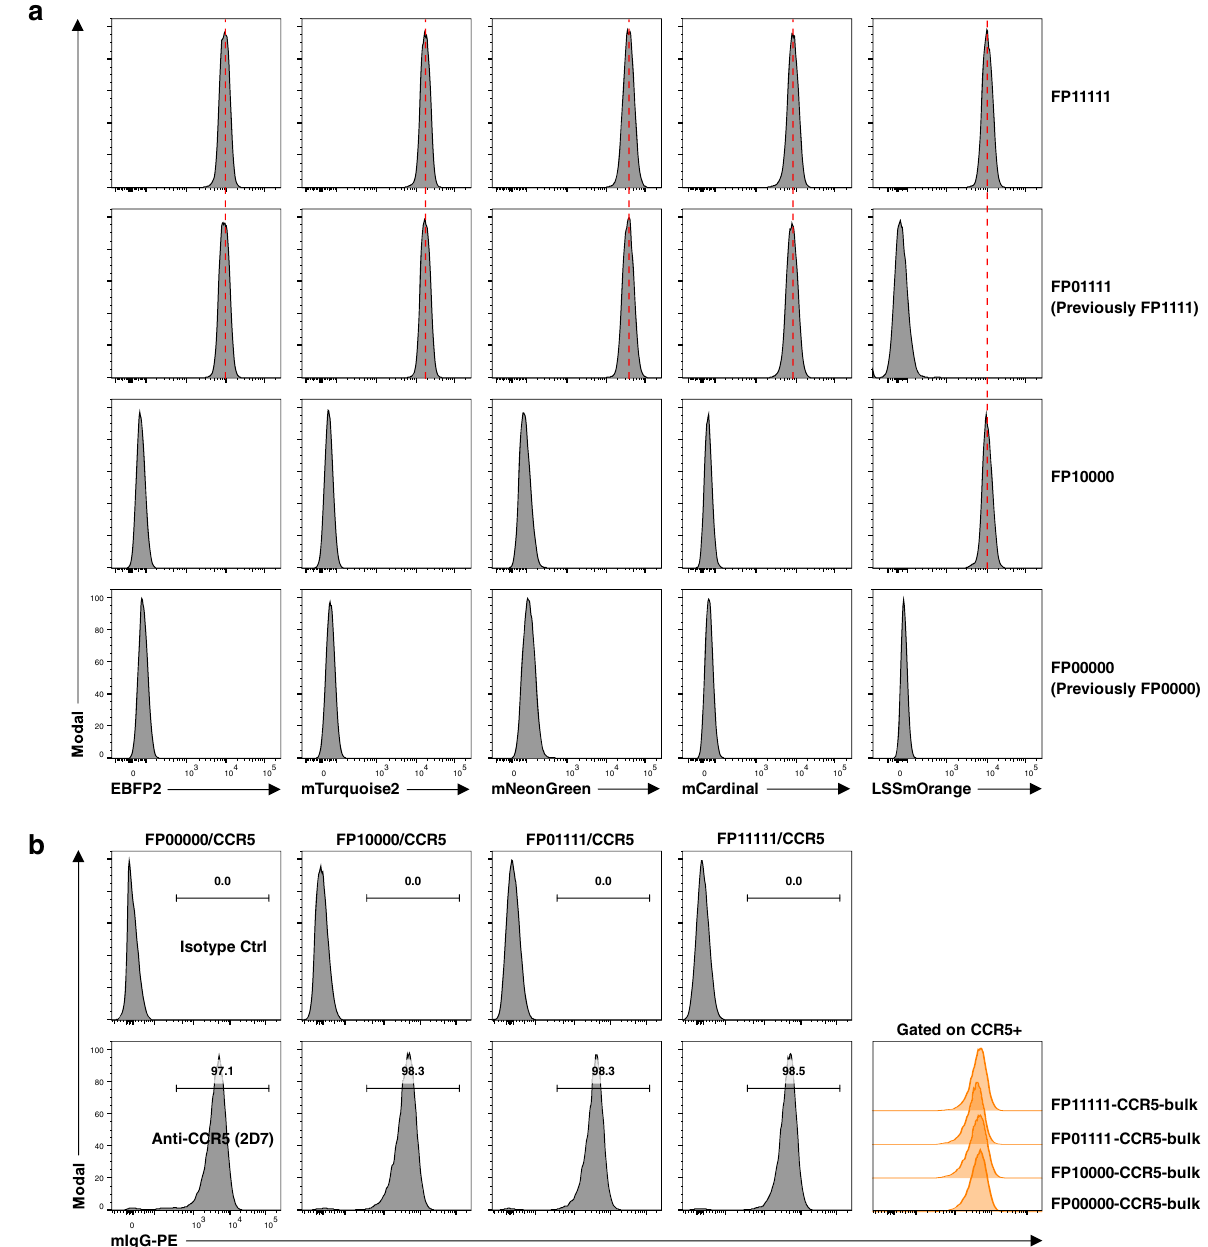
Fig. 4 Potential for expanding the 16-plex reporter cell line panel. a Generation of reporter cell lines expressing a fi fth FP, LSSmOrange. Reporter cell lines expressing none (FP0000) or four (FP1111) FPs in the basic panel were transduced to express LSSmOrange and monoclonal cell lines were generated. The parental cell lines FP0000 and FP1111 were designated as FP00000 and FP01111, respectively, and the derivative cell lines expressing LSSmOrange as FP10000 and FP11111, respectively. Dash lines in red indicate similar express levels of FPs between different cell lines. b The vast majority of puromycin- resistant transductants expressed surface CCR5 and the expression levels were comparable among different reporter cell lines with or without a fi fth FP. The four reporter cell lines generated above were transduced to express human CCR5. After puromycin selection, the bulk transductants were detected for cell surface express of CCR5. CCR5 + populations were gated and the expression levels were compared in overlaid histogram plot on the